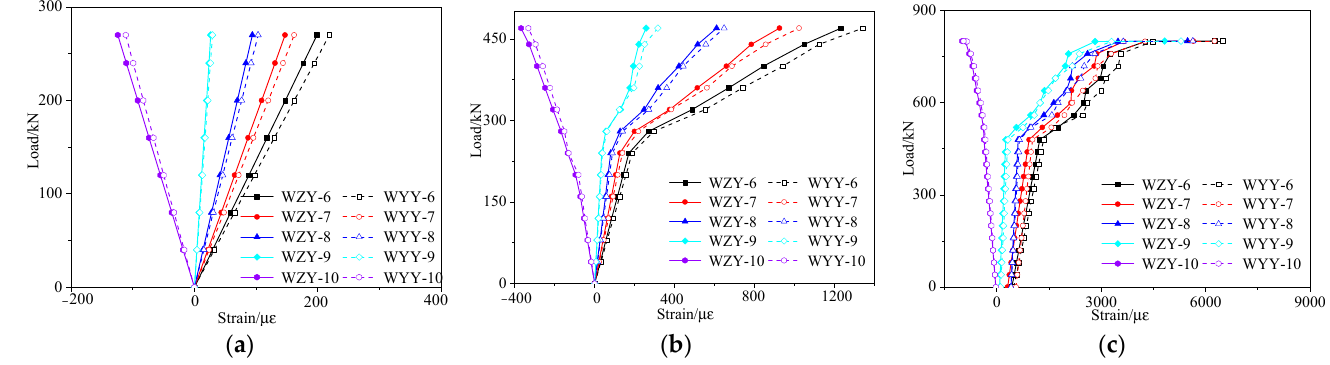
Figure 20. Strain vs. load curves of the concrete web at midspan of the repaired #3-2 girder strength- ened by steel plates. ( a ) Elastic stage; ( b ) Working stage with cracks; ( c ) The failure stage.